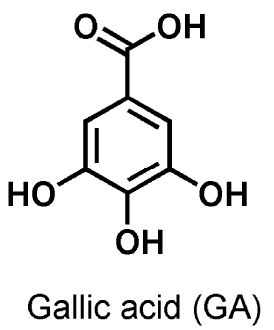
Figure 1. Chemical structure of gallic acid (GA) 1 .